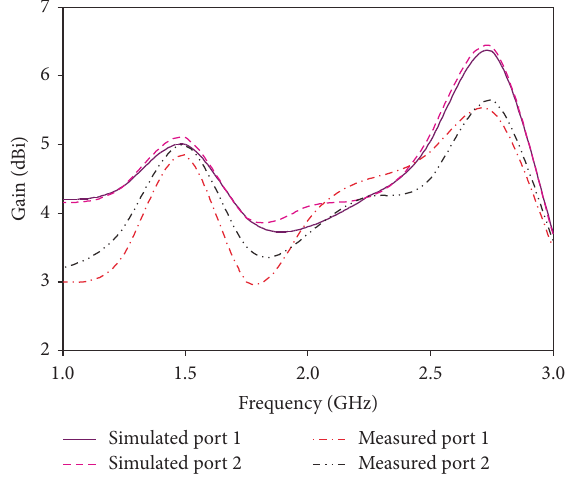
Figure 13: Simulated and measured gain for both ports.